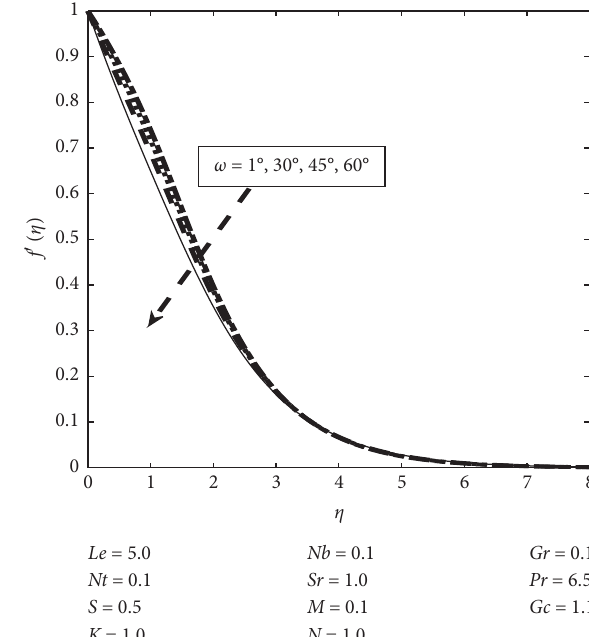
Figure 5: Velocity profile for several values of Gr